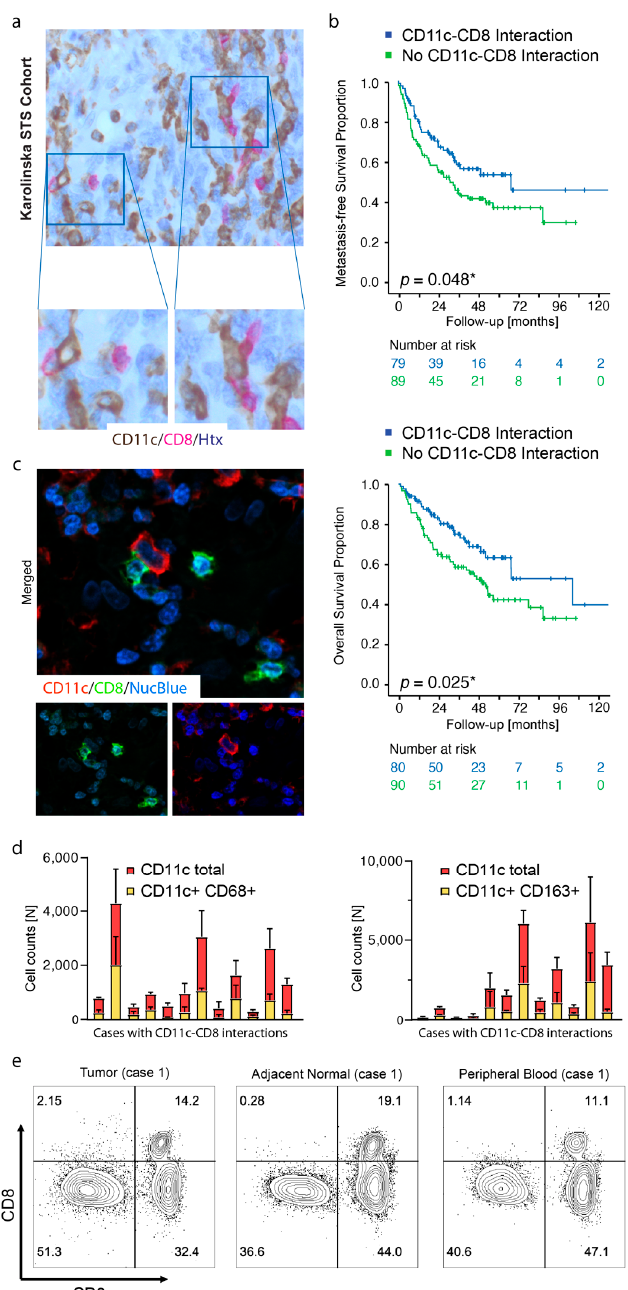
Figure 1. Spatial cross presentation in human STS is prognostic for patient survival. ( a ) Microphotograph with double immunohistochemistry (IHC) visualizing direct cell–cell interactions between CD11c+ cells and CD8+ cells; ( b ) Kaplan–Meier survival analysis using the log-rank test for com- parison between absence or presence of CD11c–CD8 cellular interactions detected by double IHC in tumors from the Karolinska STS cohort. * p < 0.05; p < 0.05 is considered significant; ( c ) Double IF (Opal multiplexing) visualizing representative single-positive CD11c+ cells and single-positive CD8+ cells. Blue pseudocolor = nuclei; ( d ) QuPath digital image quantification of CD11c+ cells with or without coexpression of the macrophage markers CD68 (left) and CD163 (right). Each bar represents an individual case displaying CD11-CD8 interactions; ( e ) Flow cytometry for CD8 and CD3 in a preparation of freshly isolated CD45+ cells from a 76-year-old male with UPS, G3 displaying intratumoral CD11c–CD8 interactions in sections from the same